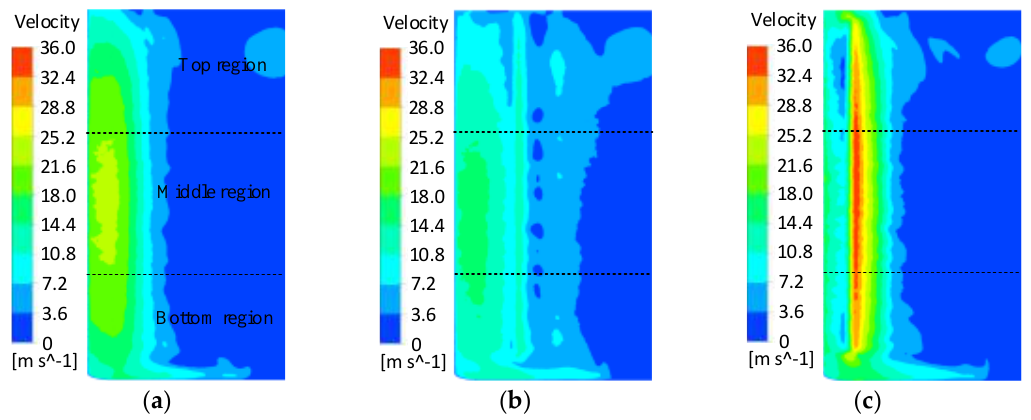
Figure 3. Electrolyte velocity distribution in the side gap when using tool A at different angles: ( a ) 30°, ( b ) 60°, ( c ) 90°.